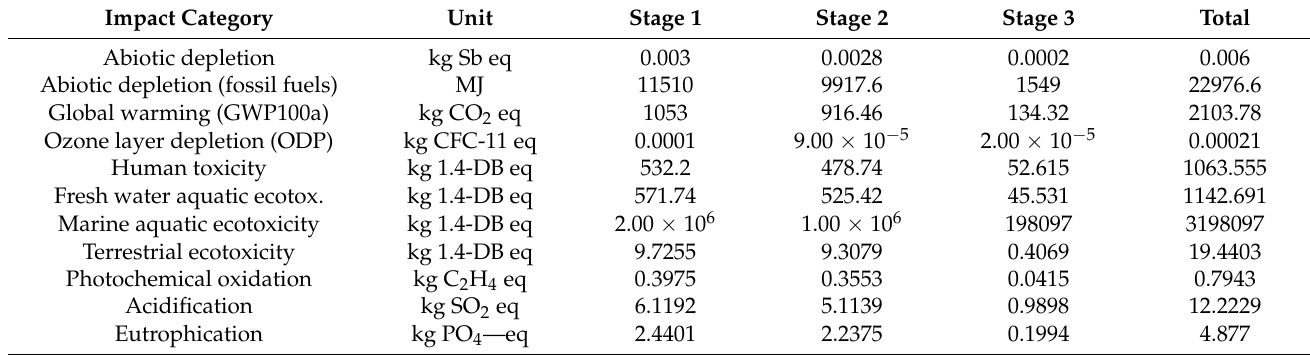
Table 21. Impacts generated by each stage of the 2-piece stopper manufacturing activity with dimensions of 26 × 44 by turning.